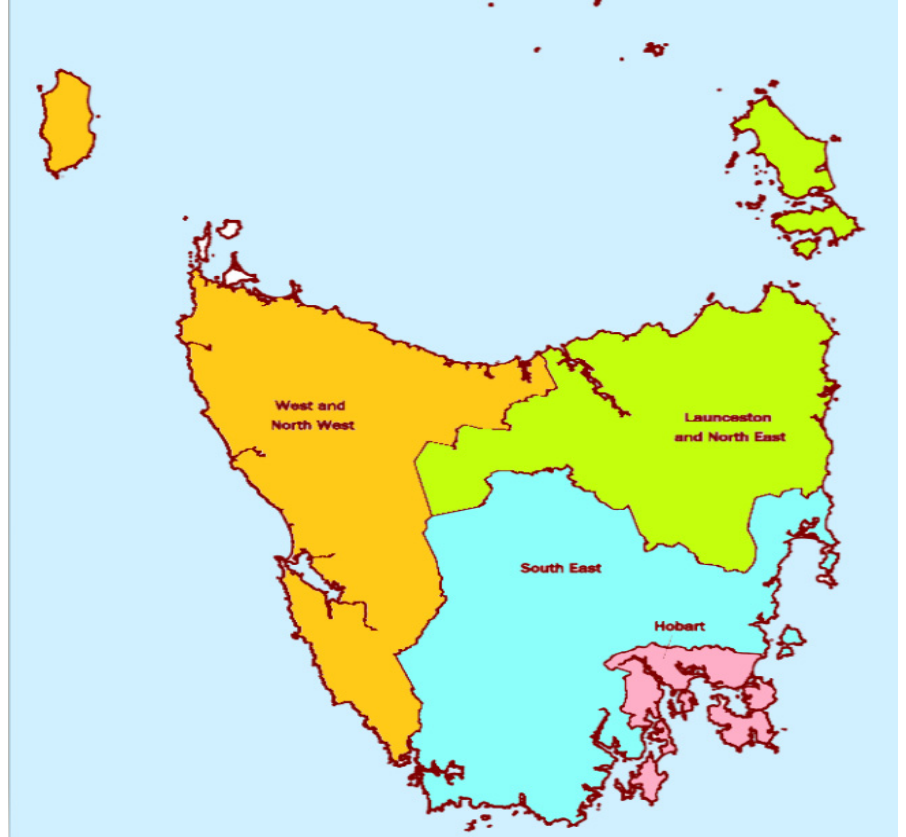
Figure 2. Statistical Areas Level 4-Tasmania.